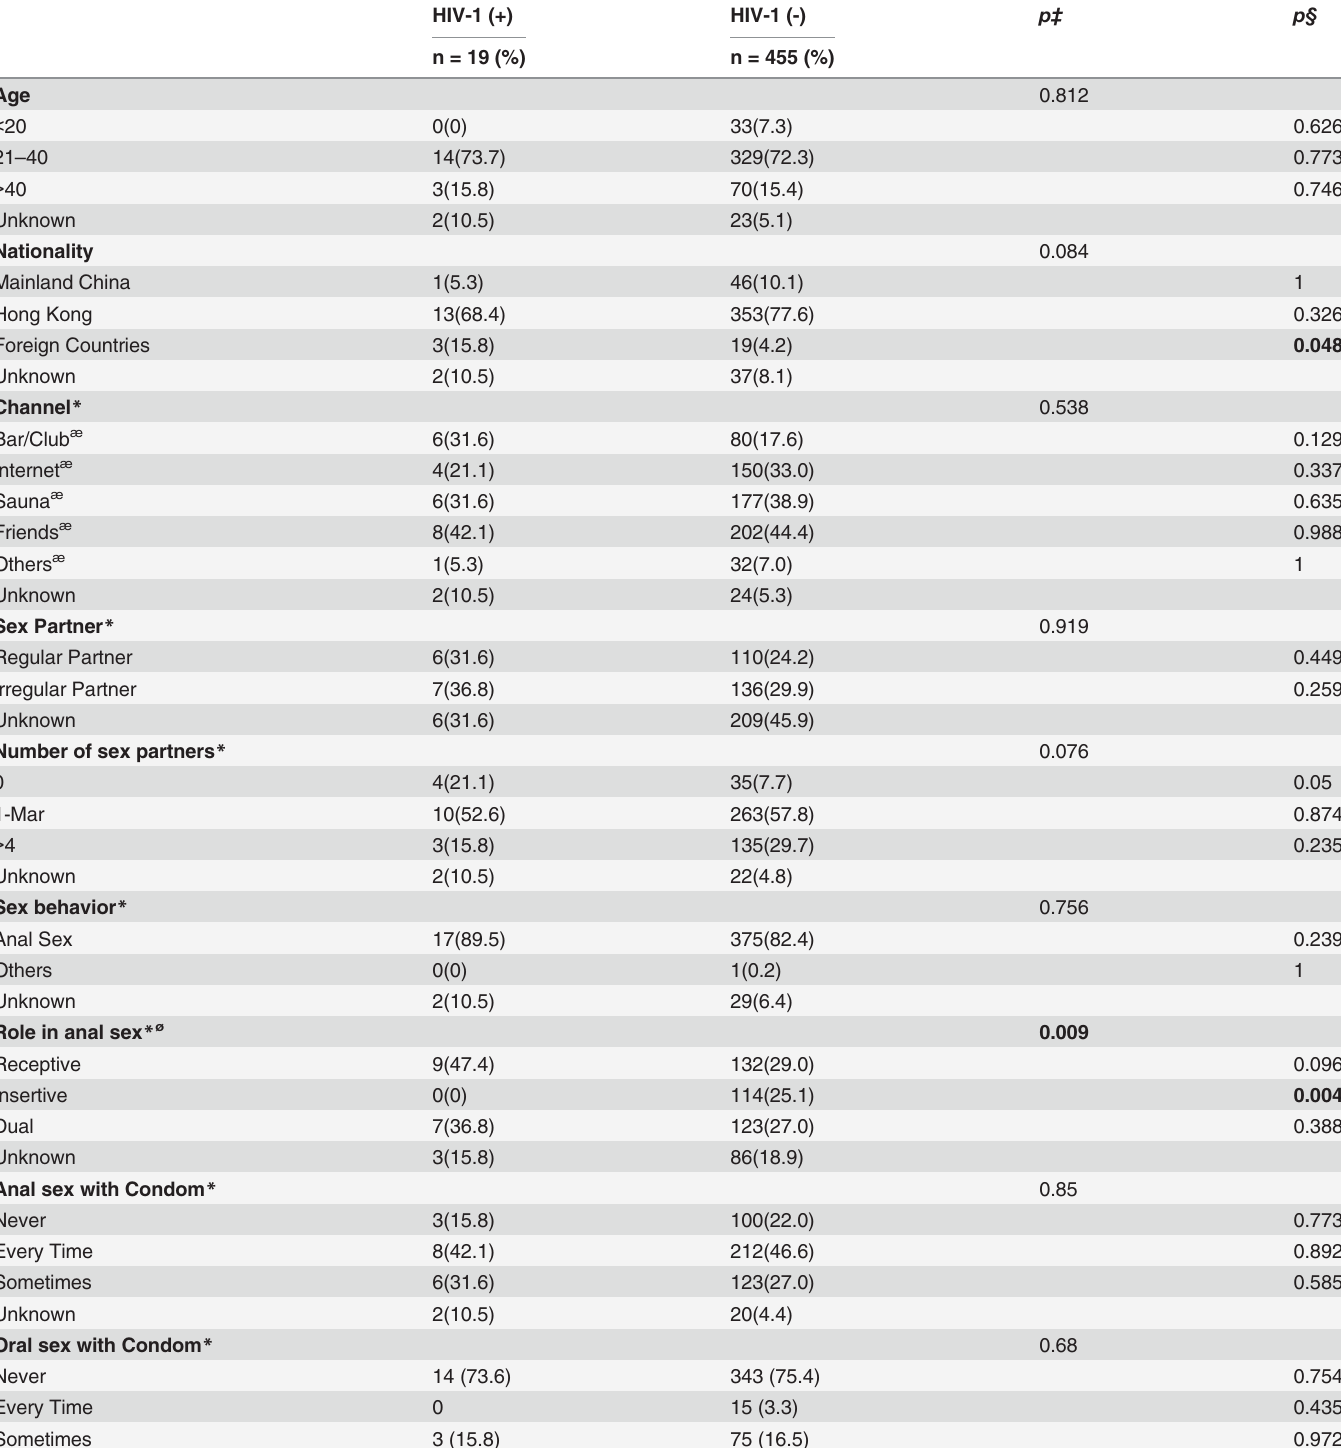
Table 3. Risk factors associated with HIV-1 infection among MSM in Hong